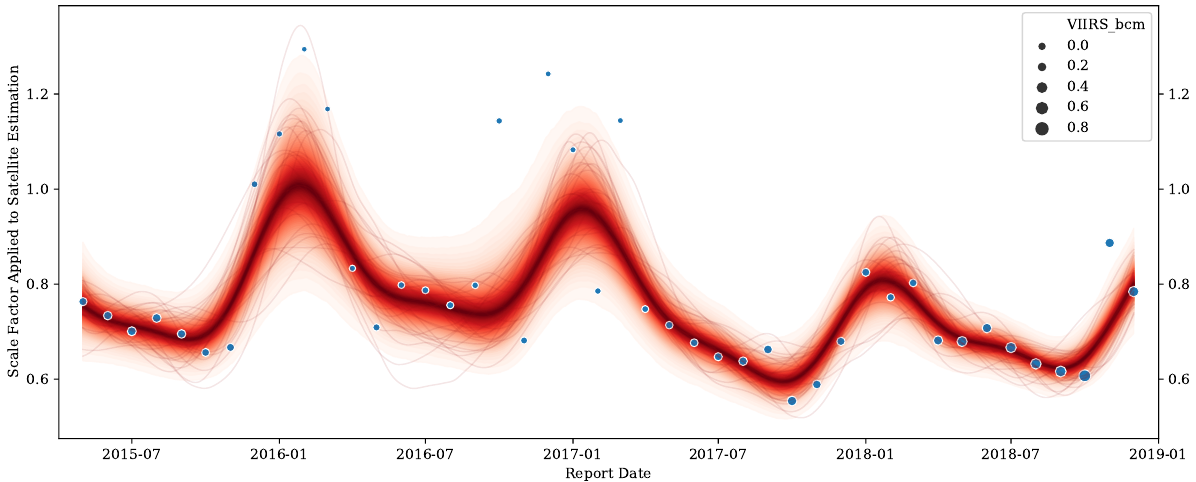
Figure 11. Posterior predictive samples showing the scale factor variations of North Dakota. Blue points stand for the observed data while red lines demonstrate thirty posterior samples. Larger points indicate greater flaring magnitude as observed by